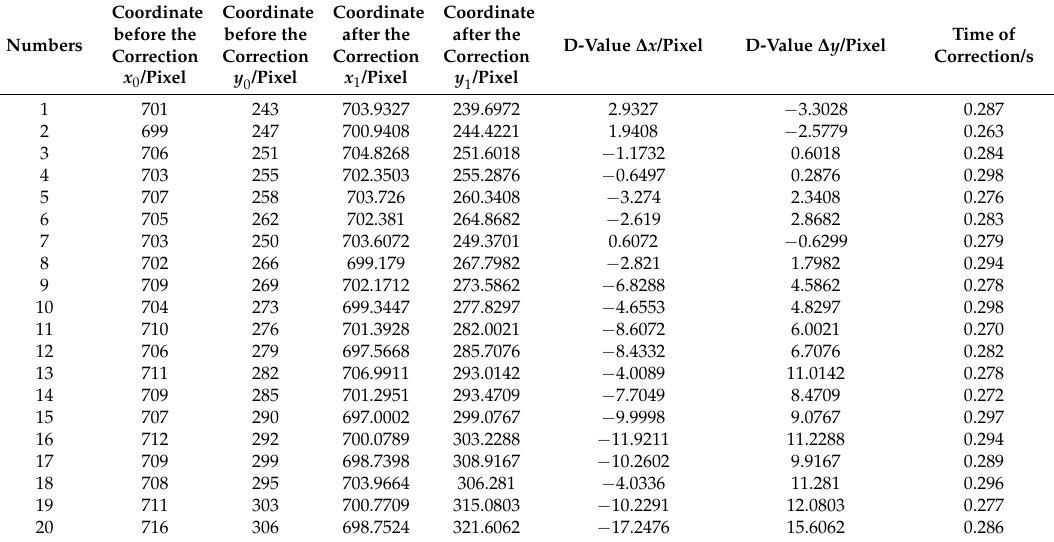
Table 4. The coordinate comparison table before and after the correction of the 0712 groups.